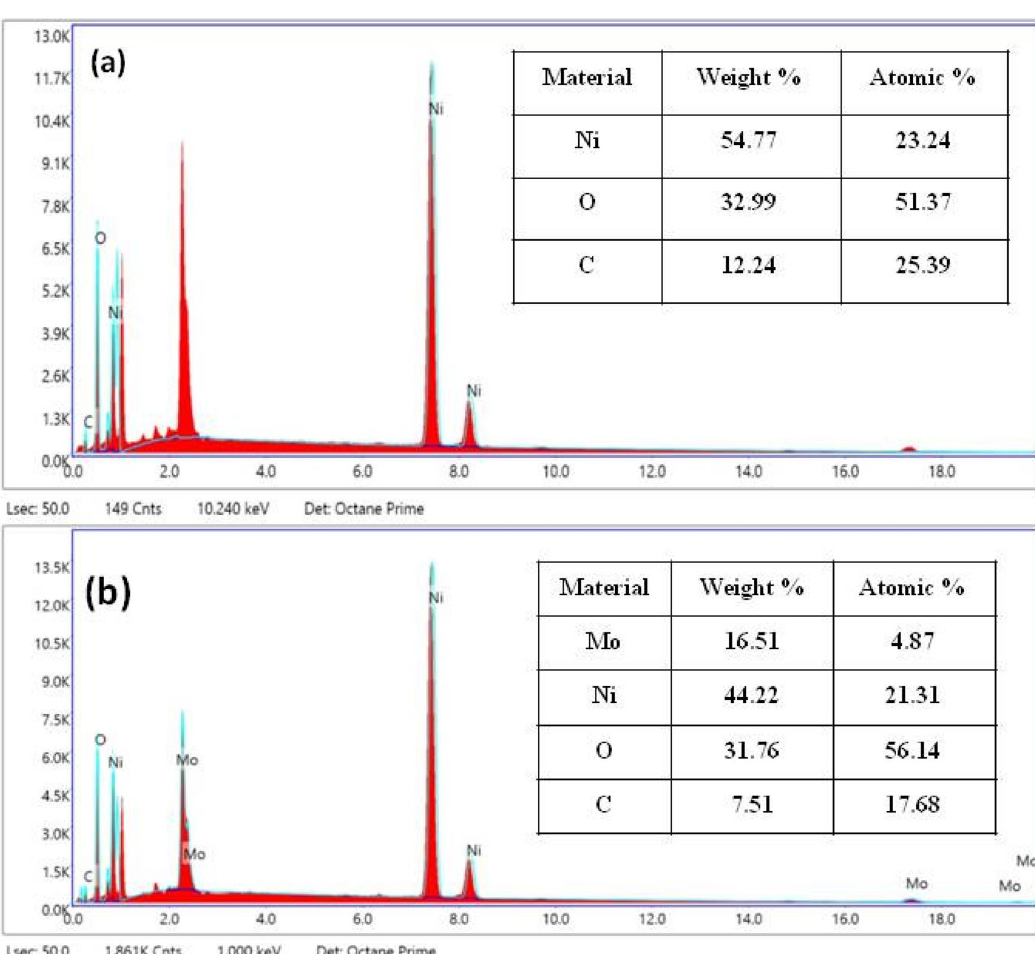
Figure 3. EDAX analysis of ( a ) NiO and ( b ) Mo doped NiO